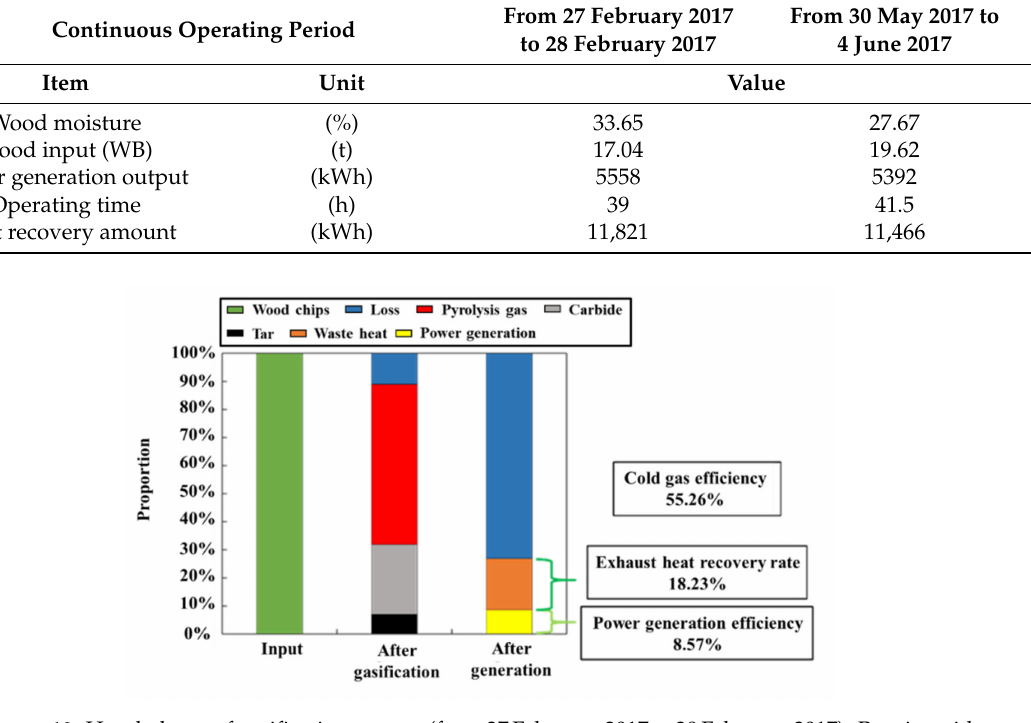
Figure 10. Heat balance of gasification process (from 27 February 2017 to 28 February 2017). Reprint with permission; JSME, 2020